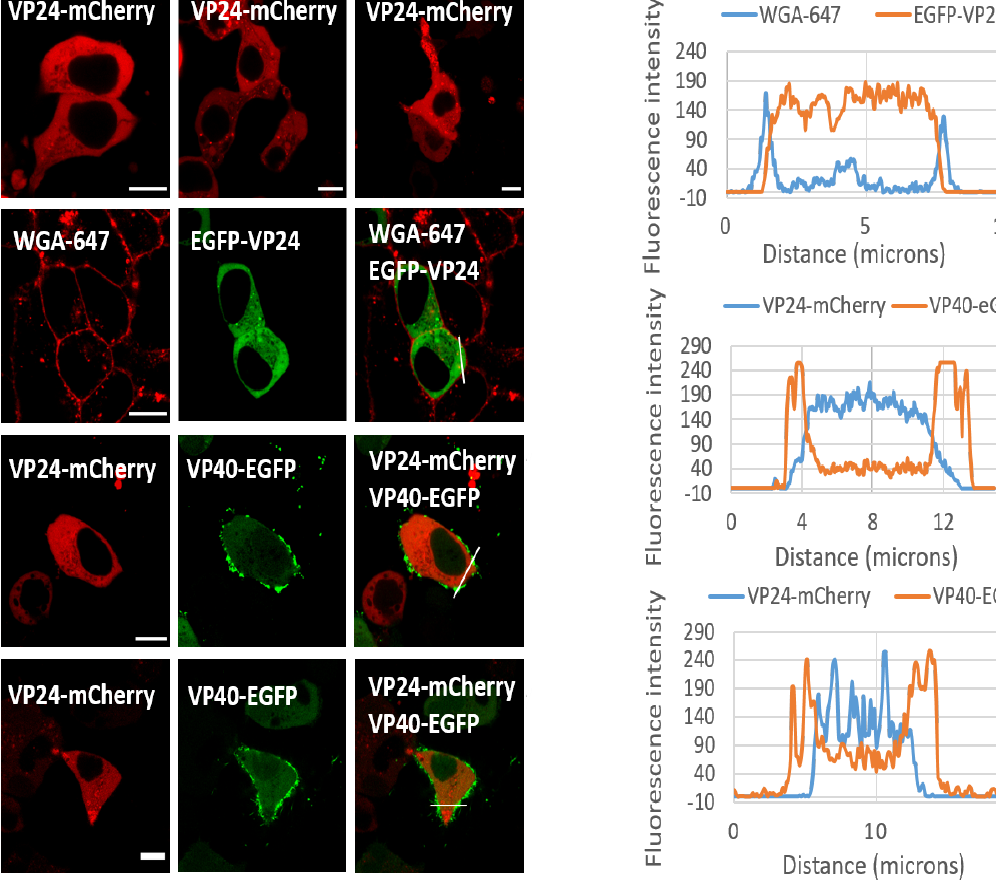
Figure 6. VP24 is not specifically associated with the plasma membrane or VP40. WGA-647 is the plasma membrane marker. EGFP-VP24 or VP24-mCherry were predominantly cytosolic and VP24 did not colocalize with WGA-647 or VP40 specifically. Lines were drawn across the cell to determine the fluorescence intensity of VP24 or VP40 at various points along the line (cytosol or membrane). Scale bar, 10 μm.